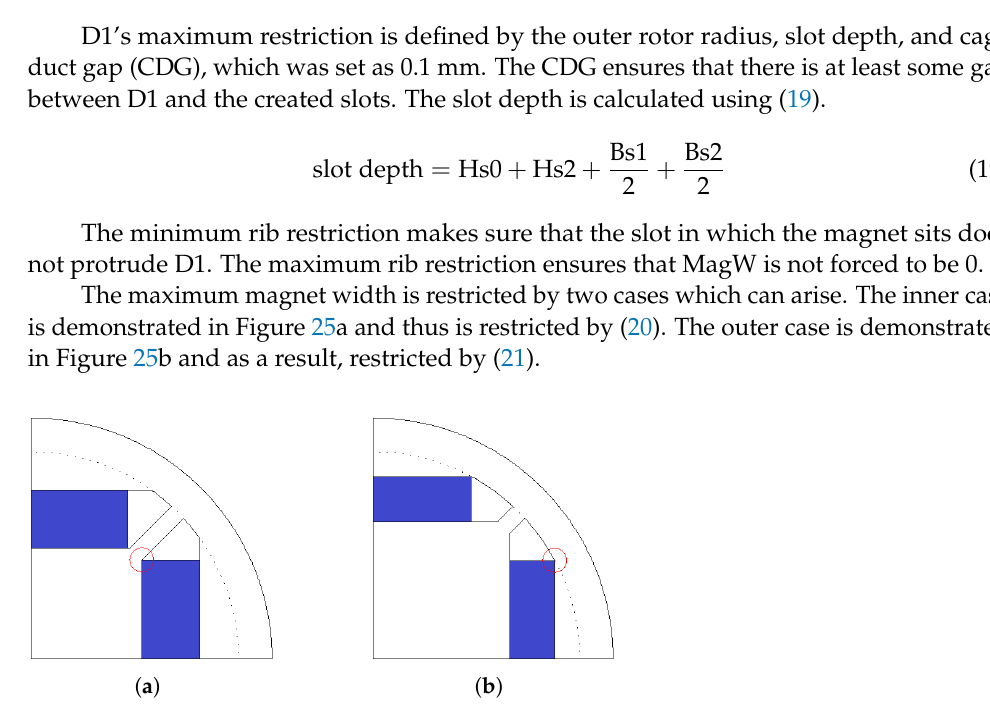
Figure 25. Possible magnet width restrictions: ( a ) inner magnet width restriction, ( b ) outer magnet width